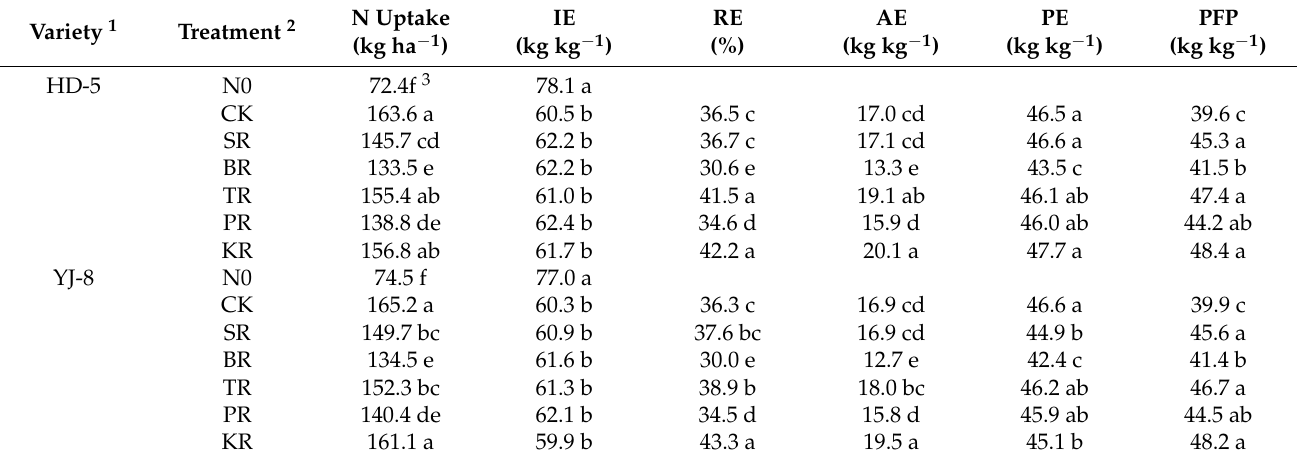
Table 4. Nitrogen uptake and nitrogen use efficiency of rice subjected to various N reduction treatments. Variety 1 Treatment 2